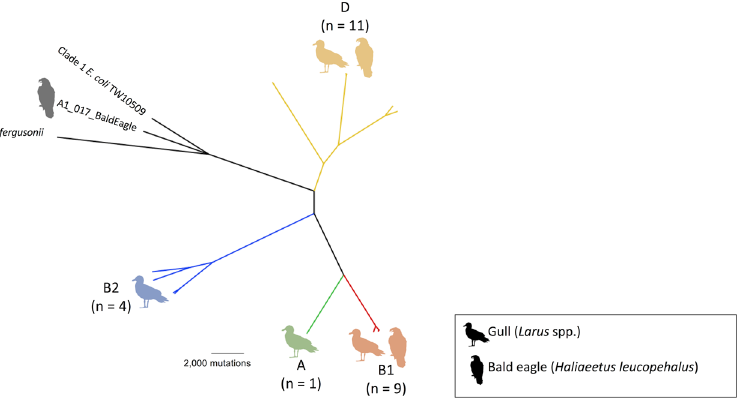
Figure 1. Unrooted clonal core genome phylogeny of 26 cephalosporin-resistant E . coli isolates originating from gulls and bald eagles in Alaska, E . fergusonii (NC_011740.1) and a Clade 1 E . coli sequence (TW10509; NZ_GL872204.1). Phylotypes A (green), B1 (red), B2 (blue) and D (yellow) are indicated at the tips with an image of a gull, bald eagle, or both, according to the species from which the isolates were obtained. The number of cephalosporin-resistant E . coli isolates belonging to each phylotype is indicated in parentheses. Silhouette images of gulls (credit: Rebecca Groom, https://creativecommons.org/licenses/by/3.0/legalcode) and bald eagles were sourced from PhyloPic